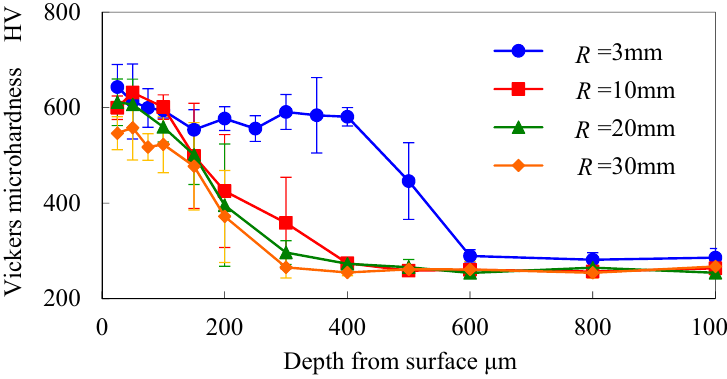
Figure 13. Hardness distributions on cross section of processed surfaces.